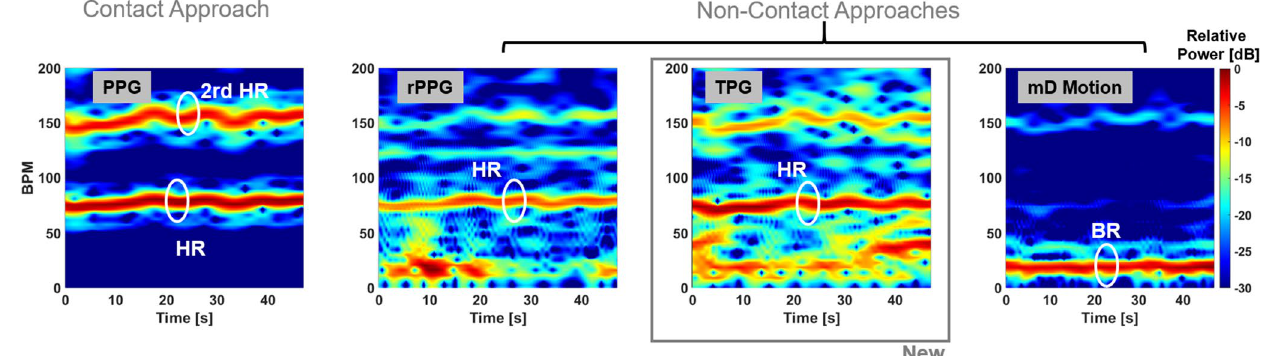
Figure 7. Time-frequency representation of the different measurement data. From the left to the right: spectrograms of PPG, rPPG, TPG, and mD phase. Based on the operation mode, they are divided into two categories: contact approach, PPG, and non-contact approaches including rPPG, TPG and mD phase. PPG, rPPG and TPG show similar spectral structures, in which the fundamental heartbeat and second-order harmonic of heartbeat are clearly visible and highlighted. The fundamental heartbeat in rPPG and TPG is the most significantly spectral energy. Motion artifacts show up in rPPG and TPG in the form of lower frequency interference close to DC due to random body movement and breathing but they are not dominant. By inspecting the TPG and the mD motion results, it validates the underline principle that the novel TPG measurement is mostly a magnitude-modulated reflectance measurement. PPG is a contact technique and requires direct skin contact. In this example, the measurement distances for the remote techniques: rPPG, TPG and mD motion are 2 m, 30 cm and 30 cm,